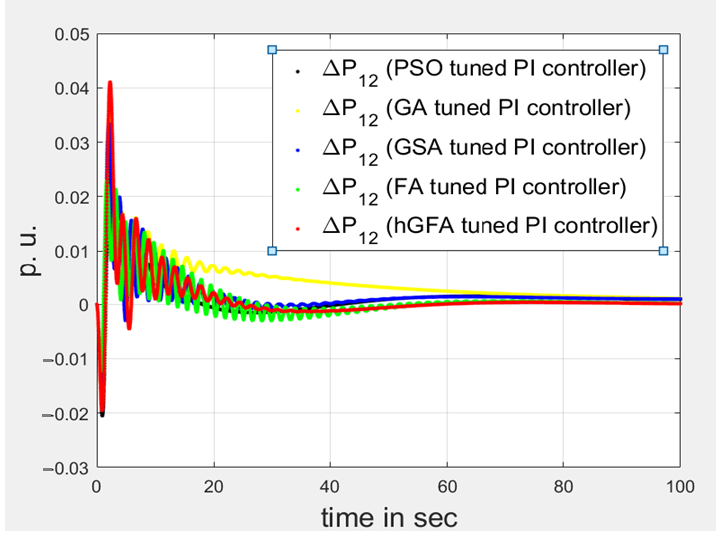
Figure 7. Perturbation in the TLP flow response of HTPS for case study-II.